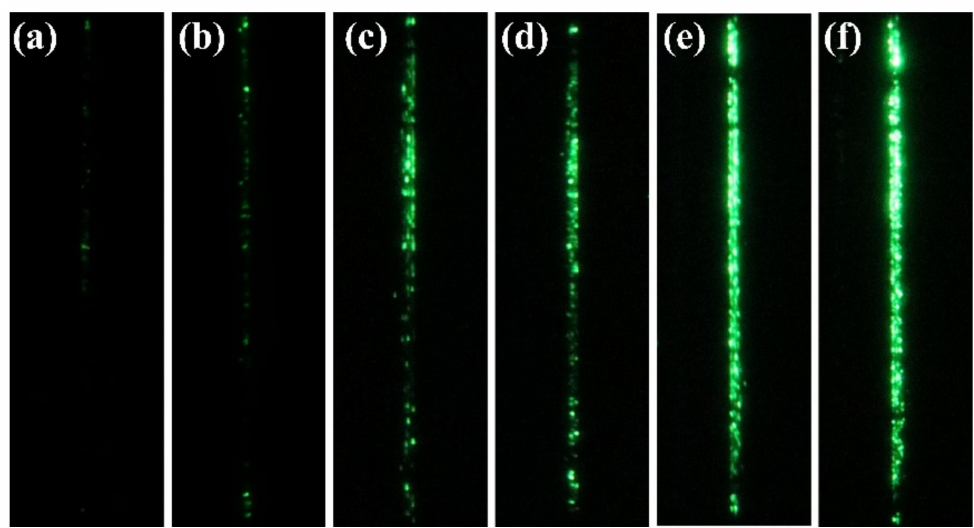
Figure 7. Emission images of two columns (200 × 2) of the arrays driven with different gate voltages. ( a ) Vg = 70 V; ( b ) Vg = 80 V; ( c ) Vg = 90 V; ( d ) Vg = 100 V; ( e ) Vg = 110 V; ( f ) Vg = 120